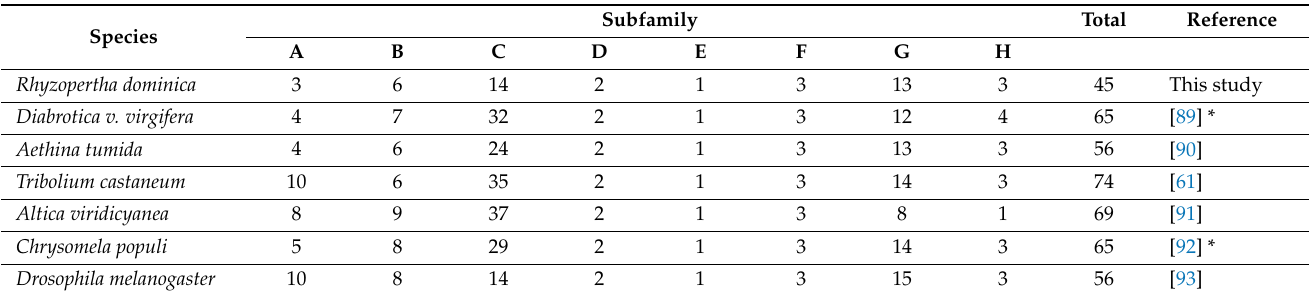
Table 2. Number of annotated genes in ABC transporter subfamilies in various coleopterans and Drosophila melanogaster